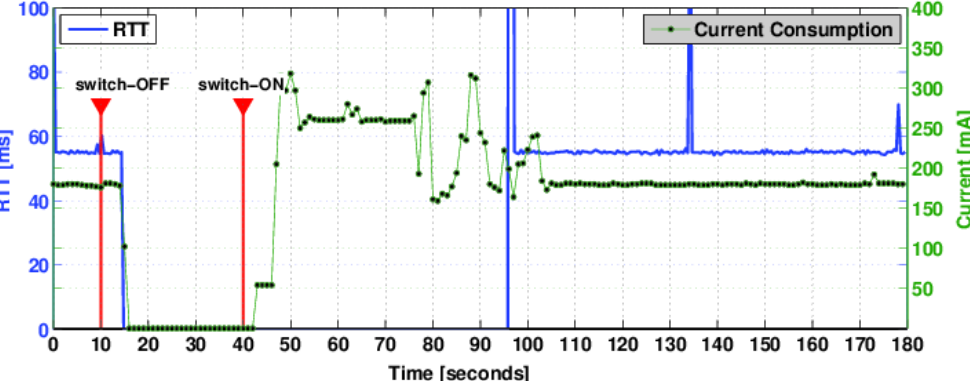
Figure 3. Time measurement for switching between sleep mode and active mode (source: